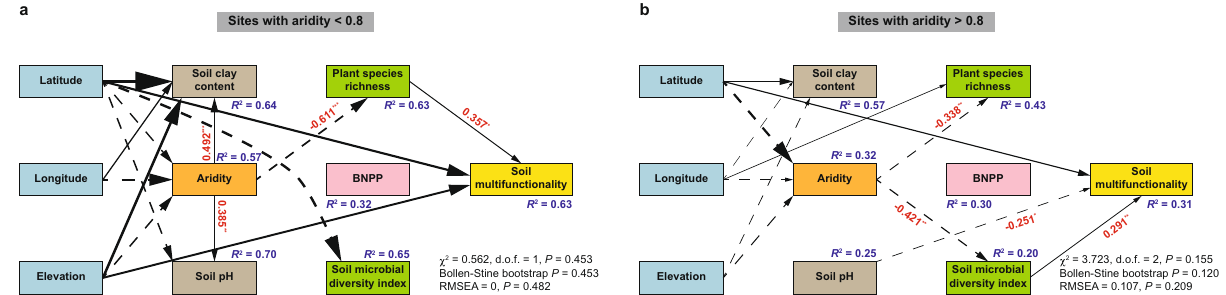
Fig. 5 Structural equation models (SEMs) accounting for the hypothesized direct and indirect relationships between aridity, soil properties (pH and clay content), biodiversity (plant species richness and the soil microbial diversity index), BNPP, and soil multifunctionality. a , b SEMs are shown for sites with aridity <0.8 ( a ; N = 54) and >0.8 ( b ; N = 76). Note that we only present signi fi cant relationships (two-sided P < 0.05) and their coef fi cients (numbers adjacent to arrows) for graphical simplicity. Latitude, longitude, and elevation of the fi eld sites are included to account for the spatial structure of our dataset, and thus their coef fi cients are not included. A priori model including all hypothesized causal relationships is available in Supplementary Fig. 17a, and all the rest of coef fi cients and their signi fi cance levels are available in Supplementary Table 5. For the SEM of sites with aridity >0.8, we remove the relationship between soil pH and BNPP with a coef fi cient close to zero to improve its overall goodness-of- fi t. Continuous and dashed arrows indicate positive and negative relationships, respectively. The thickness of the arrow is proportional to the magnitude of standardized path coef fi cients and indicative of the strength of the relationship. Asterisks indicate the signi fi cance level of each coef fi cient: * P < 0.05; ** P < 0.01; *** P < 0.001. R 2 is the proportion of variance explained by the model. Goodness-of- fi t statistics for each SEM are given (d.o.f. degrees of freedom, RMSEA root mean squared error of